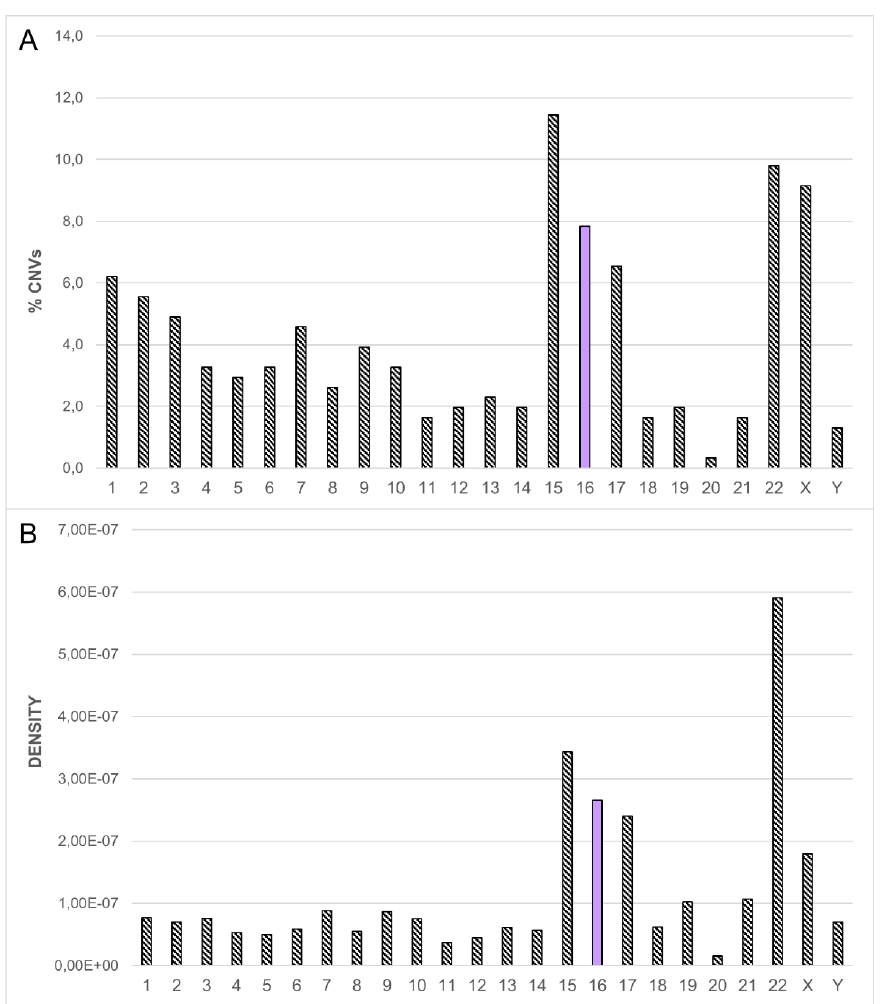
Figure 1. ( A ) Chromosomal distribution of pathogenetic and uncertain/unknown copy number variations (CNVs) in our patients ( B ) CNV density: number of CNVs in our patients in relation to the length of the chromosome. The purple column identifies chromosome 16.